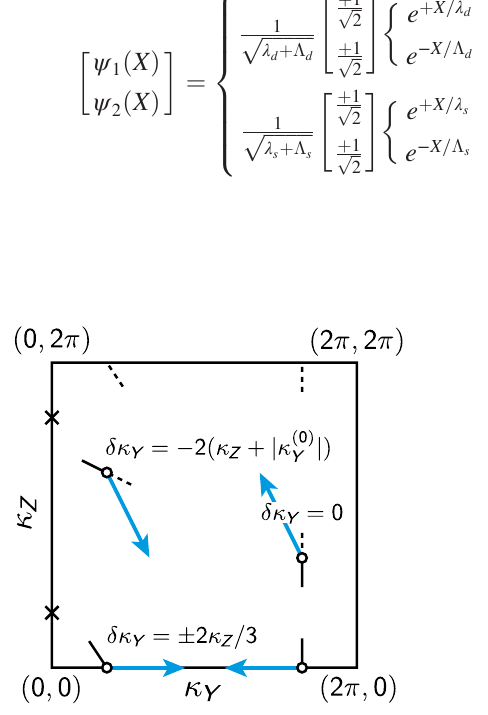
FIG. 9. Summary of solutions for the Dirac equations. Loci of the domain-wall (surface) states are represented by solid (dashed) lines, which are obtained as zero modes of the Dirac ˆ h ð(cid:2)Þ , given in Eqs. (D22) – (D25), and Hamiltonians Γ ~k Weyl Eq. (D29)]. Open circles and crosses illustrate the Weyl points ; κ projected to the ð κ Y Z Þ